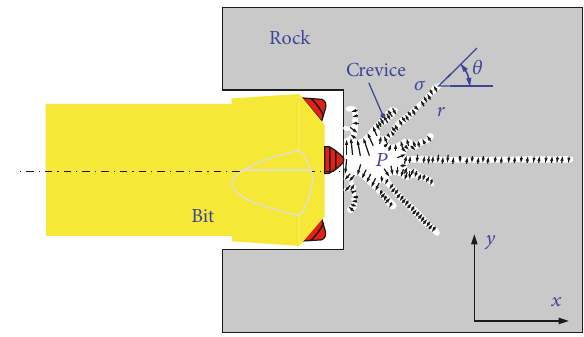
Figure 2: The bit forces of water jet assisted rock